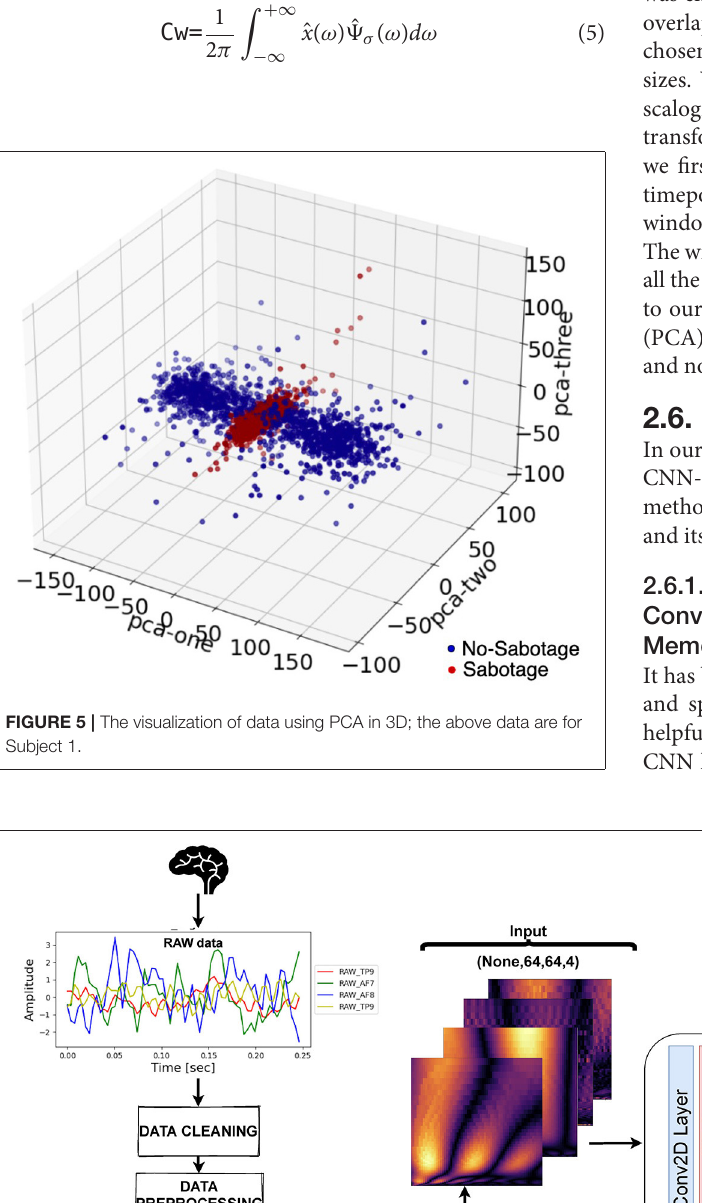
Frontiers in Human Neuroscience |